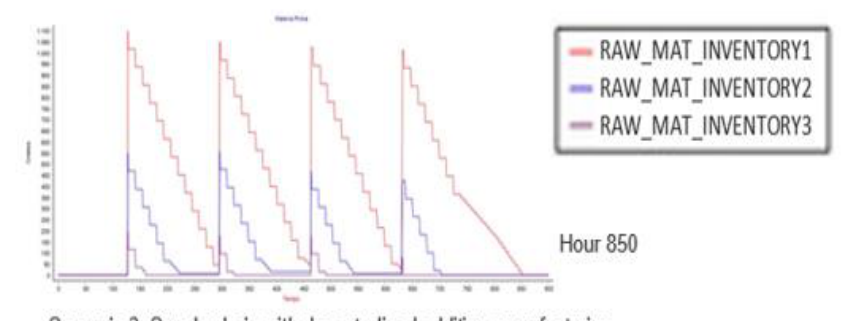
Figure 20. Behavioral contrast of raw material inventory from the established scenarios. Source: own elaboration. Simulation results obtained from Evolution software.